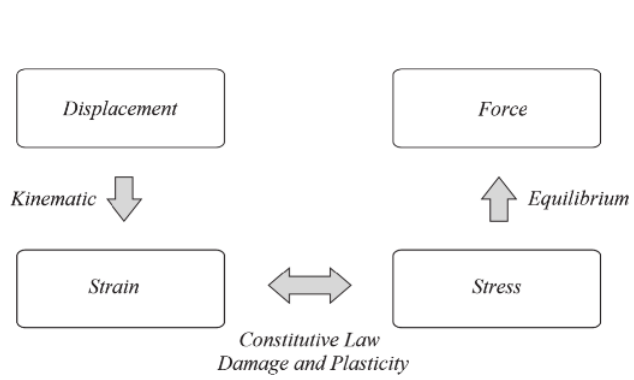
Finite element of RC and the corresponding model of lumped damage